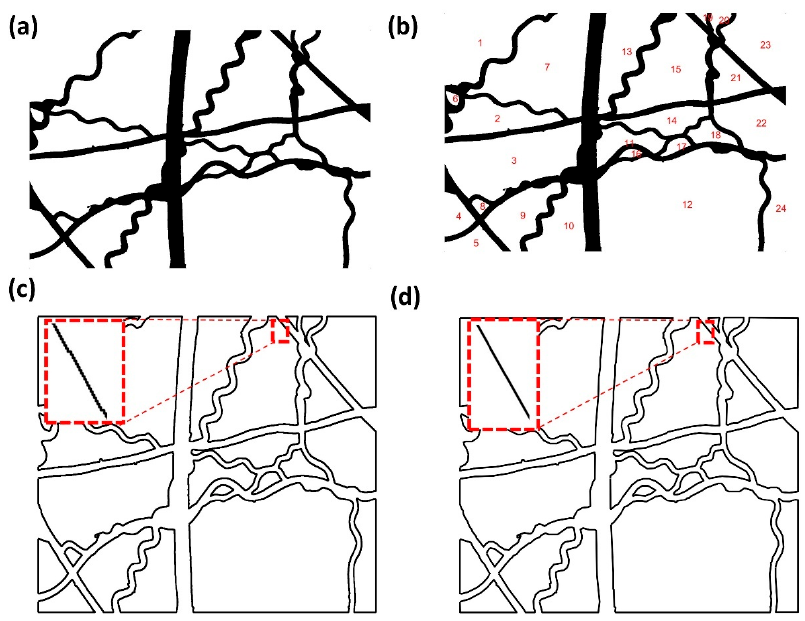
Figure 3. Vectorization of the helical-fiber nonwoven sample: ( a ) binarization image; ( b ) labelled binarization image; ( c ) boundaries extraction without refinement; ( d ) boundaries extraction after refinement.